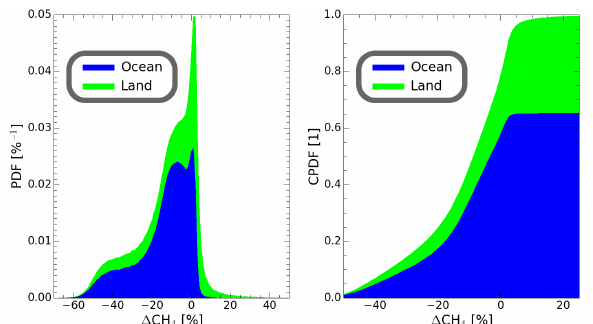
Figure 3. Probability density function (left panel) and cumulative probability density function (right panel) of the difference (cid:49) CH 4 of 1 year of GOSAT observations (2010) minus the corresponding TM5 model simulations. The figure differentiates between the con- tribution of ocean and land pixels (blue and green